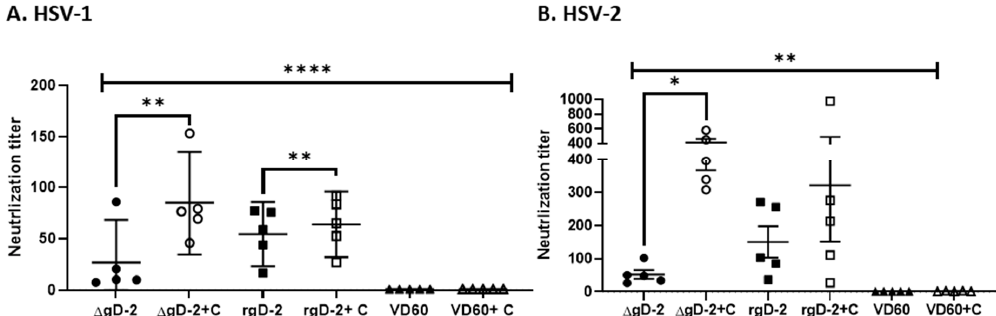
Figure 4. Complement enhances neutralization by Δ gD-2 immune serum. Neutralization of ( A ) HSV-1(B 3 x1.1) or ( B ) HSV-2 (G) infection was determined using a plaque assay with serial dilutions of heat-inactivated immune serum from Δ gD-2, adjuvanted recombinant gD protein (gD-2) or VD60 lysate-vaccinated mice in the absence or presence of 10% rabbit complement (C) compared to plaques formed in the absence of serum. The serum dilution that inhibits 50% of plaque formation is shown as mean ± sd ( n = 5 mice). **** p < 0.0001, ** p < 0.01 and * p <0.05, paired t -test comparing neutralization titer with or without complement and two-way ANOVA with Tukey’s corrections for multiple comparisons.